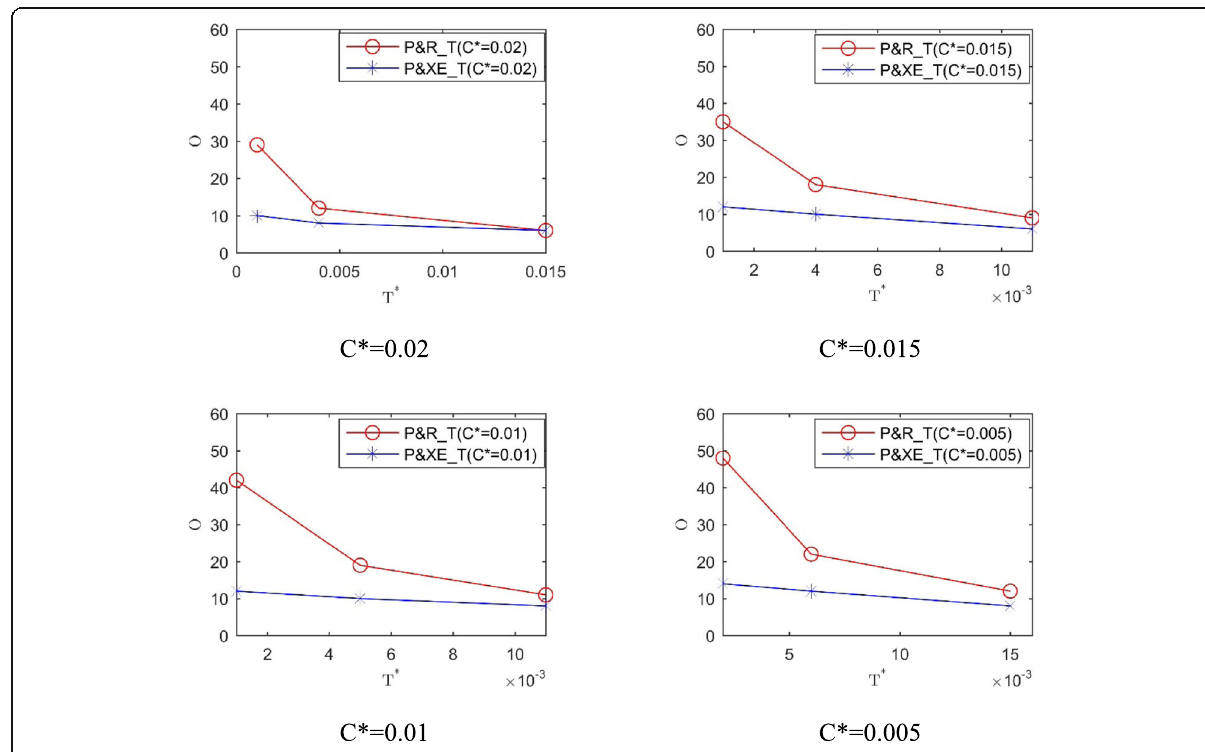
Fig. 12 User storage overhead comparison under the same T * and C * constraints for n = 30 and 5 ≤ m ≤ 10